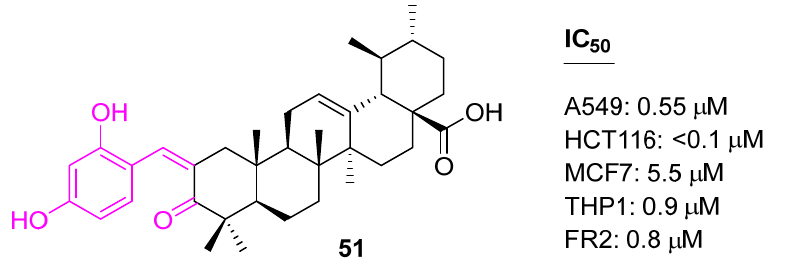
Figure 35. Structure of 51 .